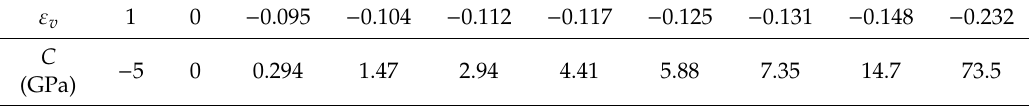
Table 4. Compressibility and volumetric strain of the gelatin